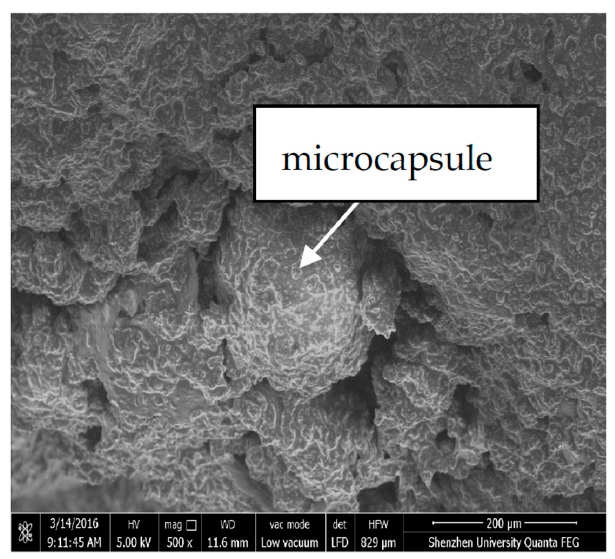
Figure 2. Specimens for test.